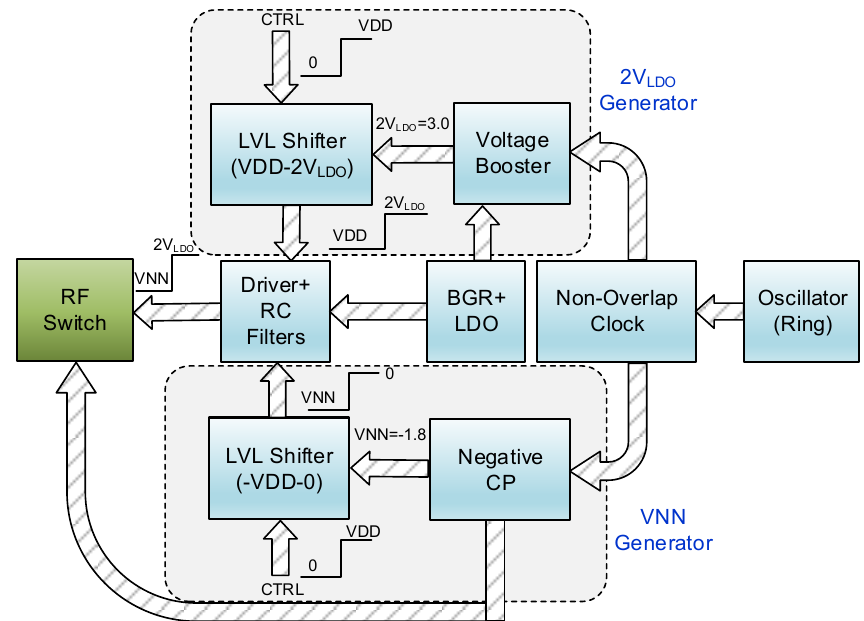
Figure 1. Block diagram of the designed SPDT RF switch and analog